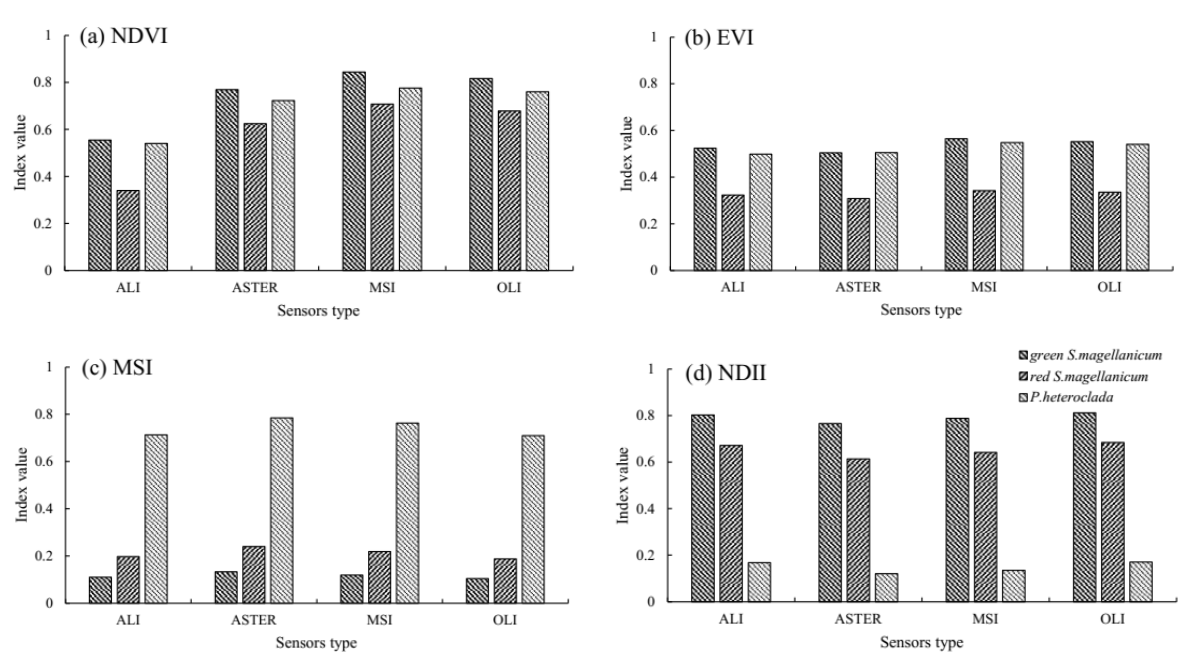
Figure 14. Equivalent spectral indices of P. heteroclada and S. magellanicum (Pang et al. 2019). Note that the EVI values for ASTER were calculated using the formula marked EVI 2 in Table 1, whereas the EVI values for the other three sensors were calculated using the formula marked EVI in Table